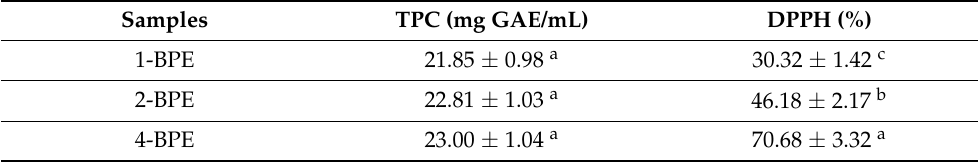
Table 5. TPC and antioxidant activity of the